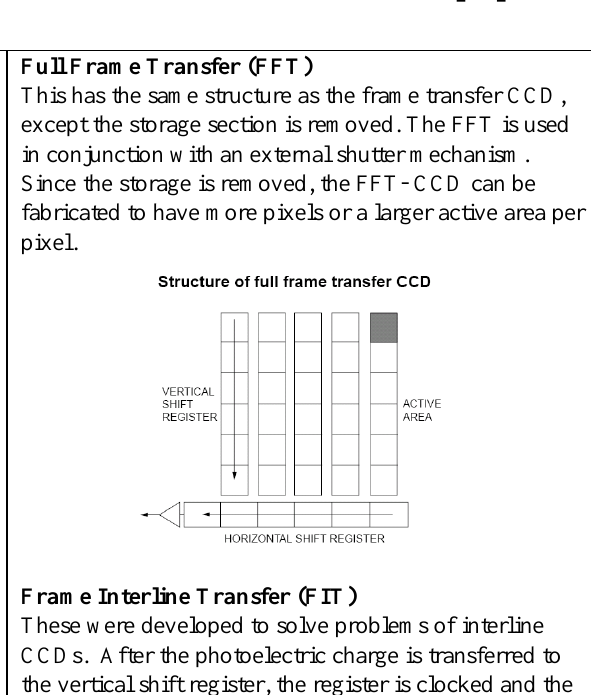
Figure 35. Comparison of different CCD cameras. Pictures taken from Hamamatsu